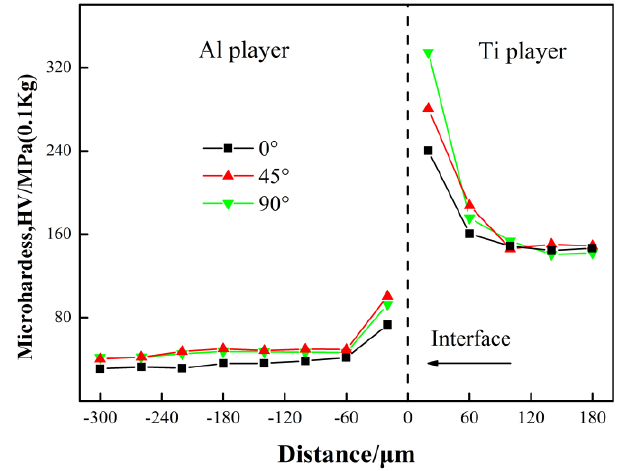
Figure 8. Micro-hardness near Ti/Al interface of the Ti/Al laminated composites.